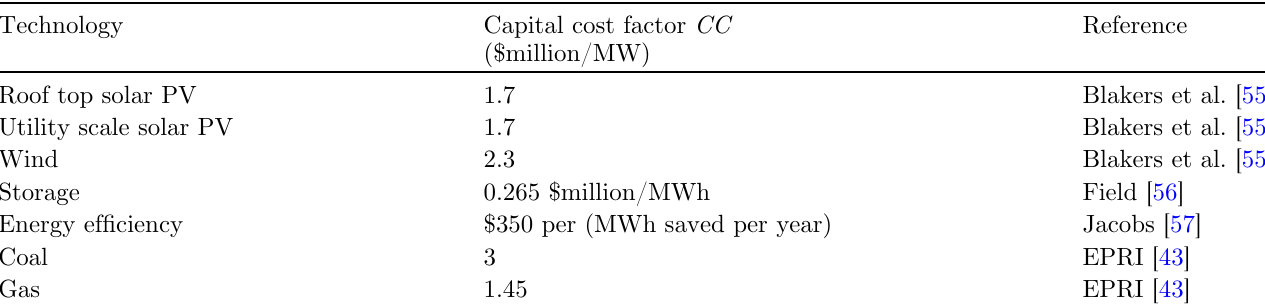
Table 7. Capital cost factors for different energy generation, storage or ef fi ciency